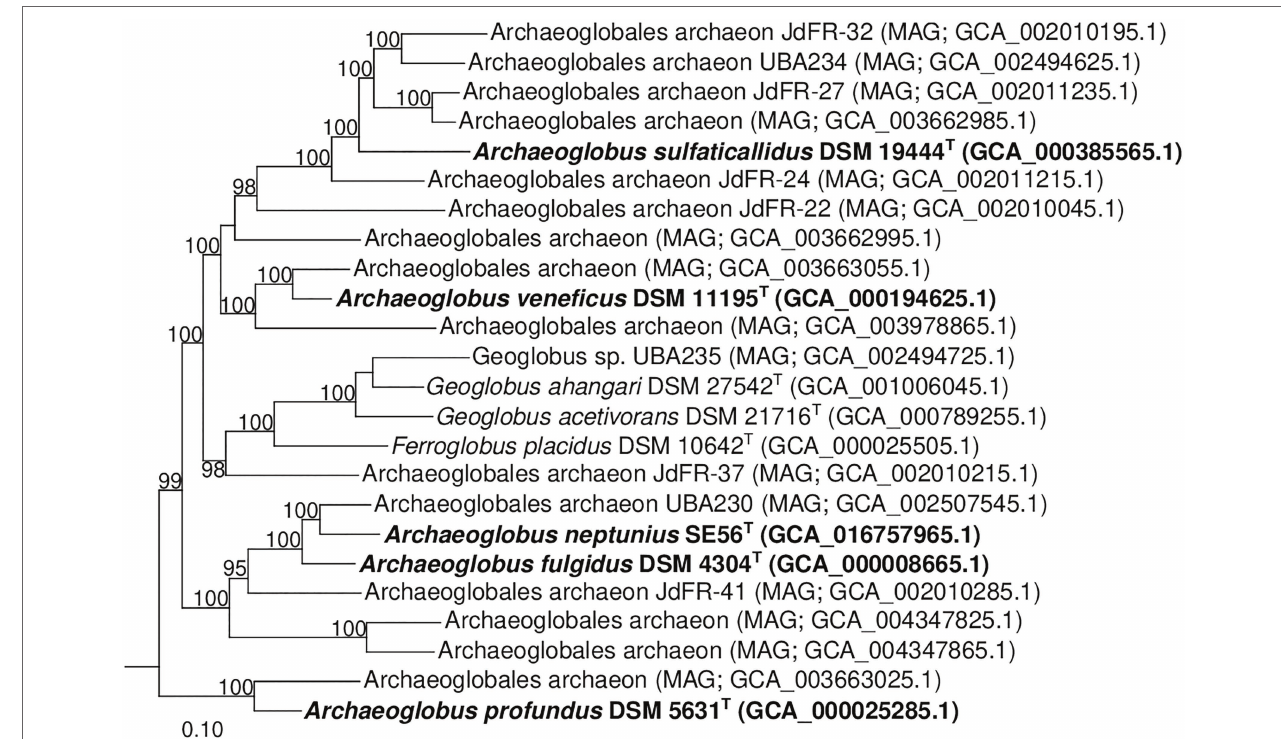
FIGURE 5 | Phylogenomic placement of A. neptunius and other species of family Archaeoglobaceae based on concatenated partial amino acid sequences of 122 archaeal conservative proteins [Parks et al., 2018; taxonomic designations correspond with Genome Taxonomy DataBase (GTDB)]. The tree was built using the PhyML 3.0 program (Guindon et al., 2010). For rooting, the tree sequences from 62 genomes of type strains of type species of genera of “ Halobacteriota ” phylum (correspond with GTDB) were taken. All assemblages of Archaeoglobaceae family according to GTDB Release 05-RS95 are shown on the tree. Bootstrap values above 90% are shown at the nodes. Bar, 0.10 changes per